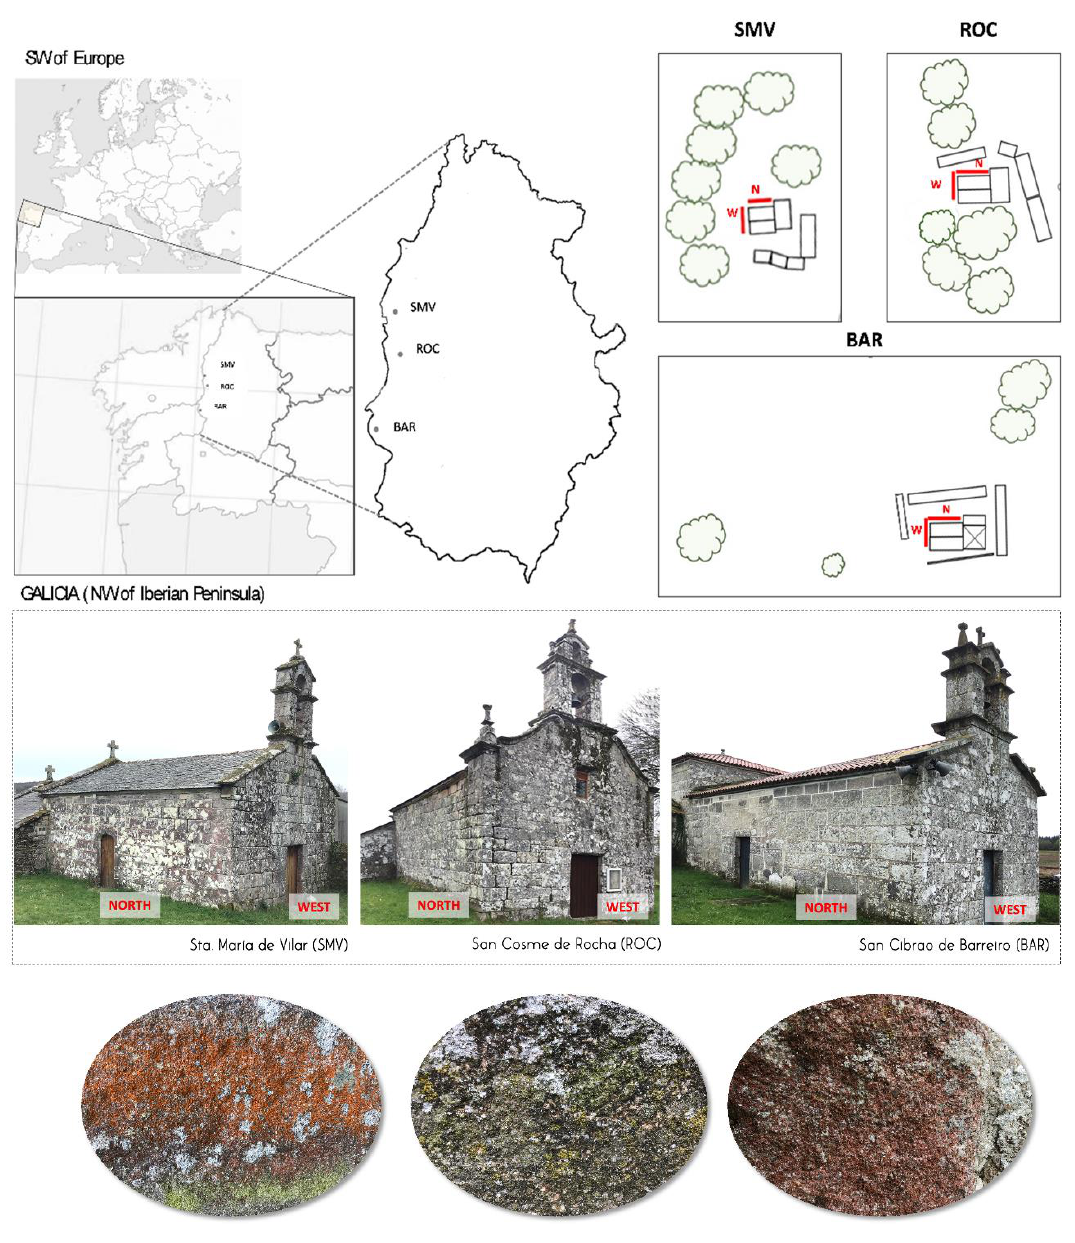
Figure 1. Location and photographs of the north and west façades of the SMV, ROC and BAR churches (Galicia, in the NW of the Iberian Peninsula) and the different biopatinas.